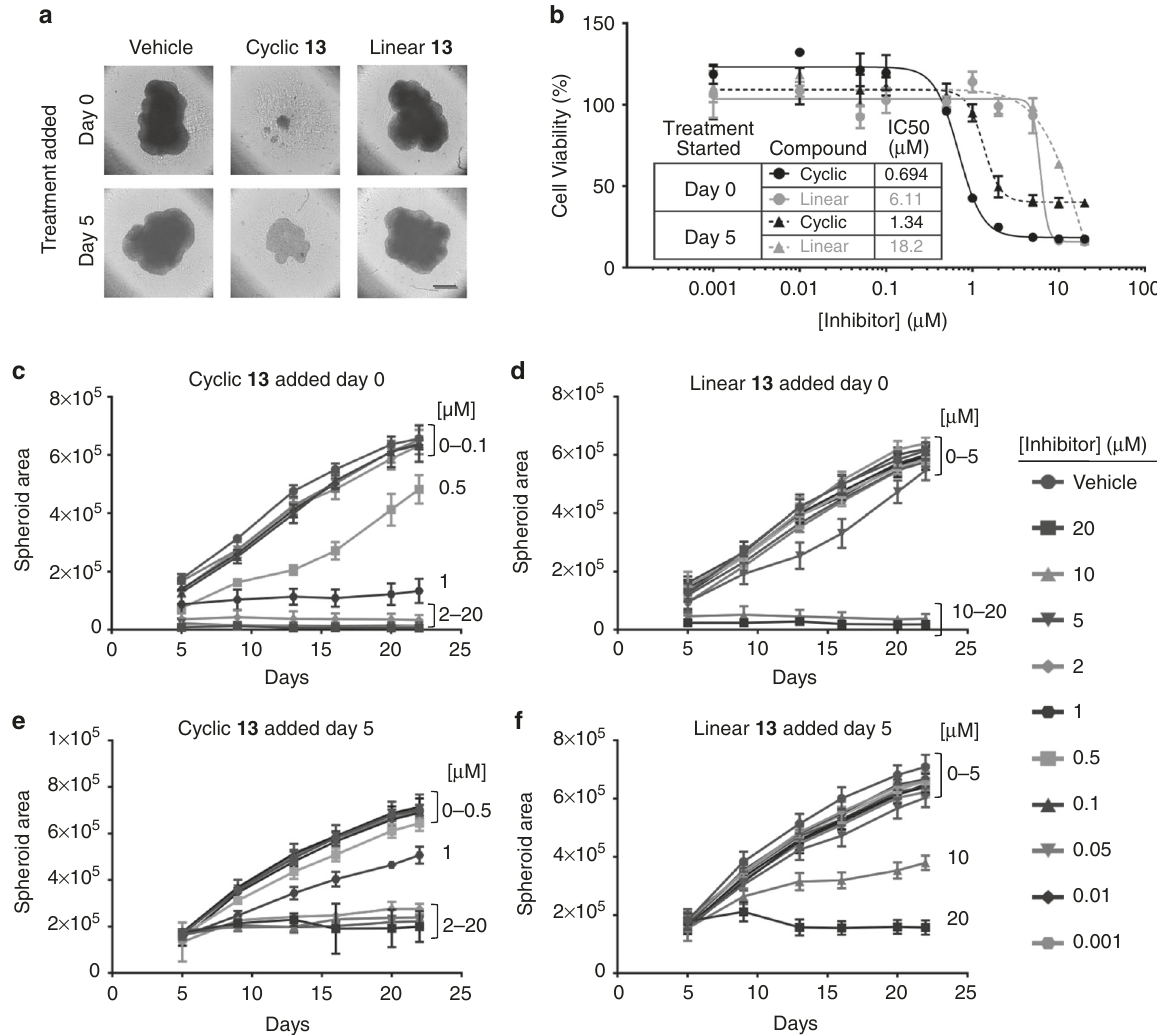
Fig. 5 Macrocycle 13 slows prostate cancer spheroid cell growth. a Representative images of tumor spheroids imaged from above on day 20 and treated with vehicle or 2 µ M oligomer. Scale bar represents 400 μ m. b End point viability measurements taken on day 22 using PrestoBlue. c – f Time course of spheroid areas calculated from images taken throughout the experiment. Data are presented as mean and SD ( n = 5 ( c – f ), n = 2 ( b